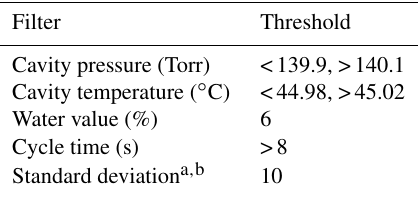
Table 7. Parameters used in GCWerks for automatic CRDS data filtering until September